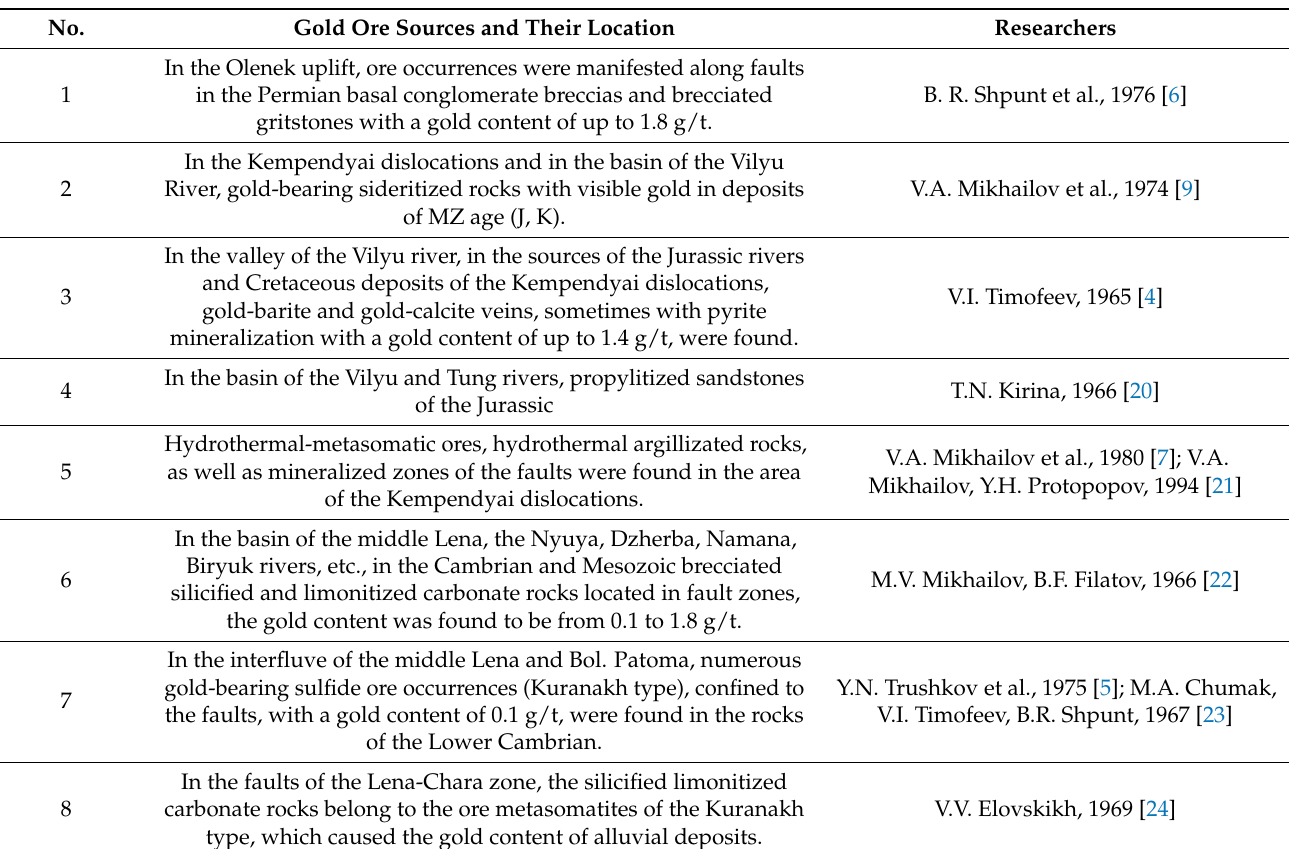
Table 1. Gold ore occurrences in the supposed hydrothermal-metasomatic formations of PZ-MZ age (east of the Siberian